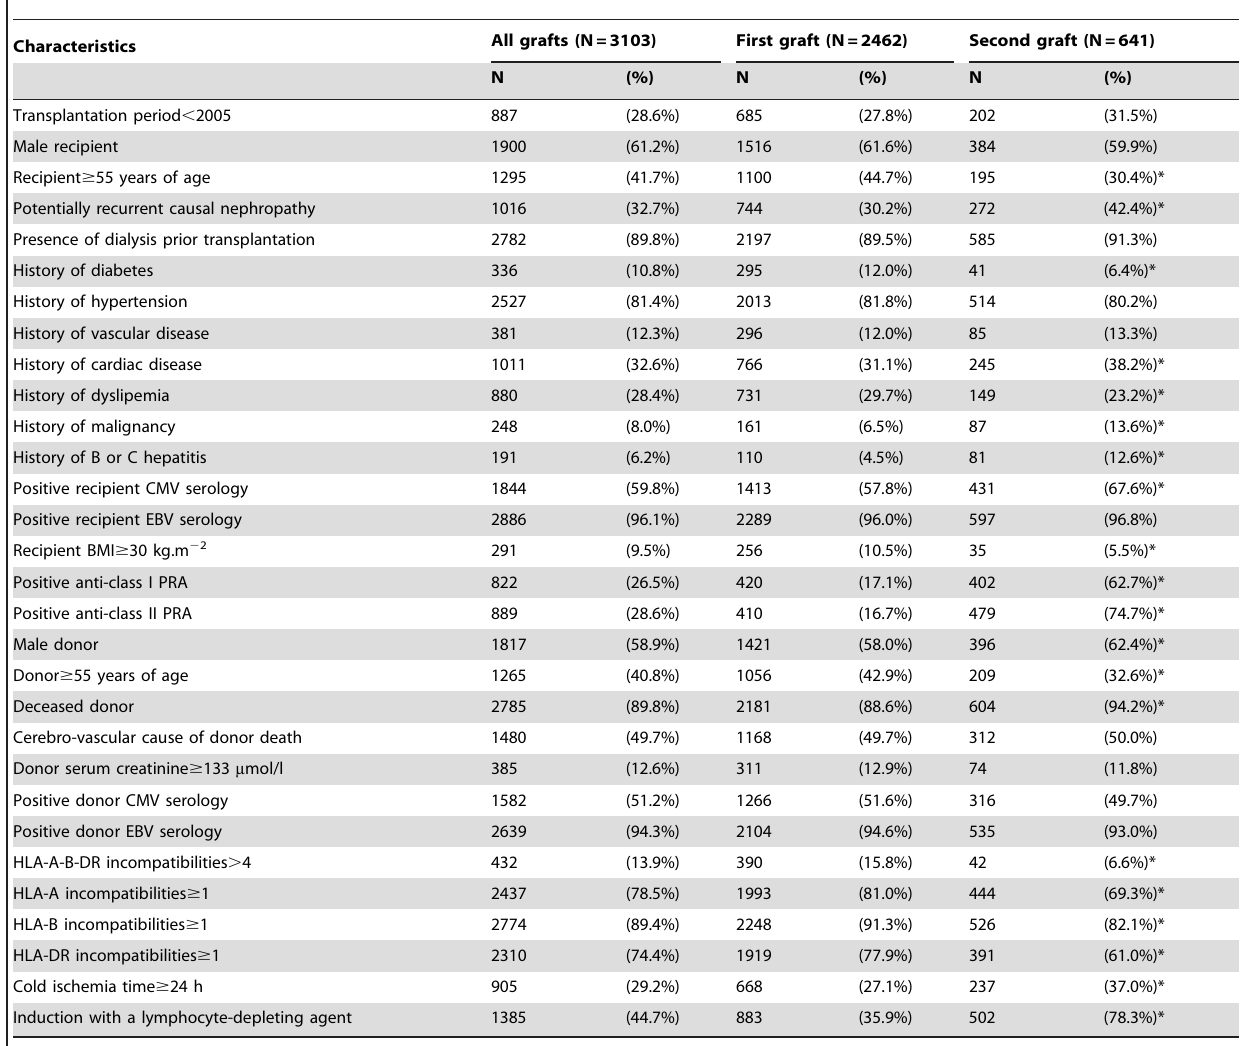
Table 1. Demographic and baseline characteristics of primary and second transplants performed in the DIVAT network between January 1996 and November